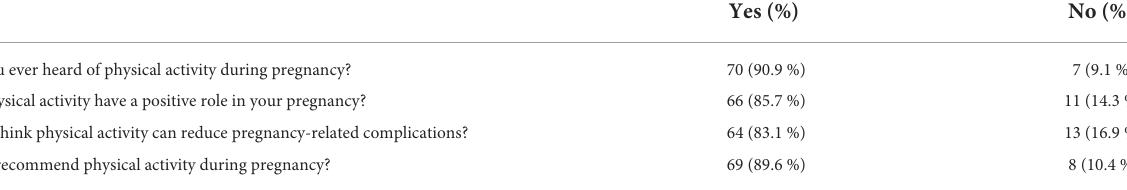
TABLE 2 Participants’ responses to questions on knowledge of physical activity ( n = 77).